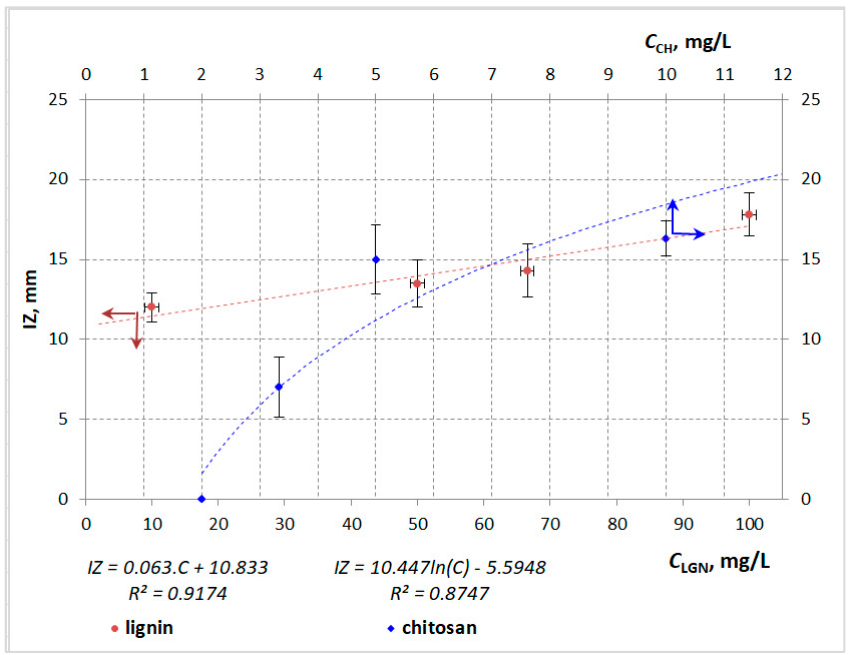
Figure 1. Dependence between the antimicrobial activity of chitosan and lignin (expressed as IZ, mm) and the biopolymer concentrations against S. aureus .